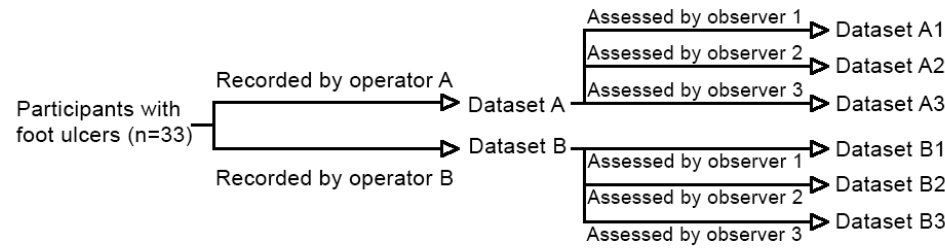
Figure 6. Schematic overview of datasets.